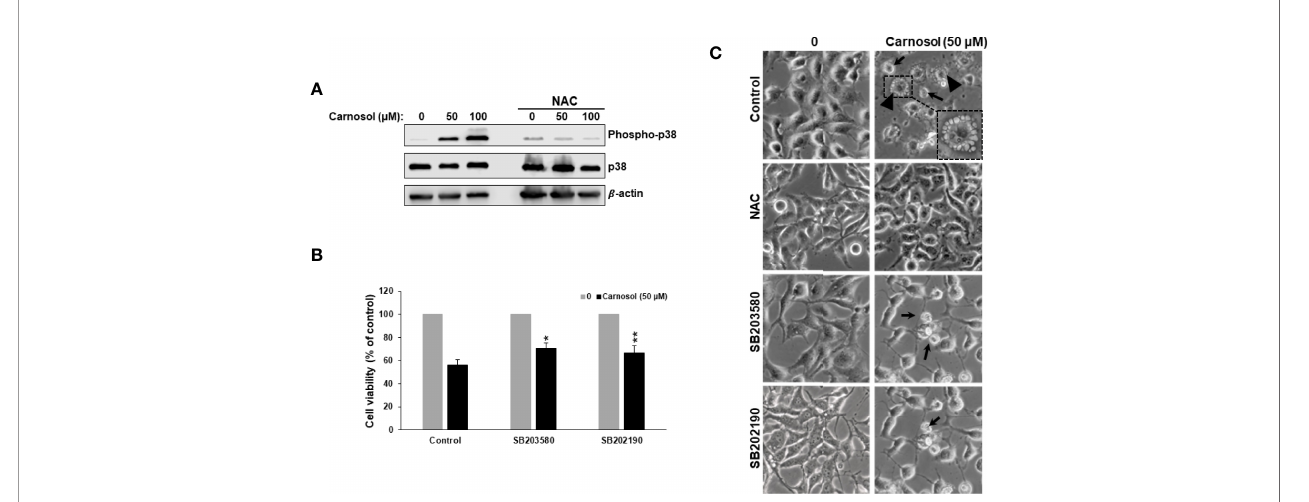
FIGURE 5 | ROS-dependent activation of p38MAPK by carnosol. (A) Concentration-dependent increase of phospho-p38 protein in carnosol-treated MDA-MB-231 cells. Cells were pre-treated with the ROS scavenger NAC (10mM) before adding carnosol at the indicated concentrations for 24 hours. Whole cell lysates were analyzed by Western blot for phospho-p38, total p38, and b -actin (loading control). (B) Chemical inhibition of p38 activation reduced carnosol-induced cell death. MDA-MB-231 cells were pre-treated for 1h with or p38 inhibitors, SB203580 (50µM), or SB202190 (50µM) before treatment with carnosol (50µM) for 24hours. Cell viability was determined as described in Material and Methods. Data represent the mean ± SEM of 3 independent experiments. The student ’ s t-test was performed to determine the signi fi cance (*p<0.05 and **p<0.005). (C) Morphological changes in carnosol-treated MDA-MB-231 cells. Cells were observed under EVOS XL Core Cell Imaging System (Life Technologies) at 400X.